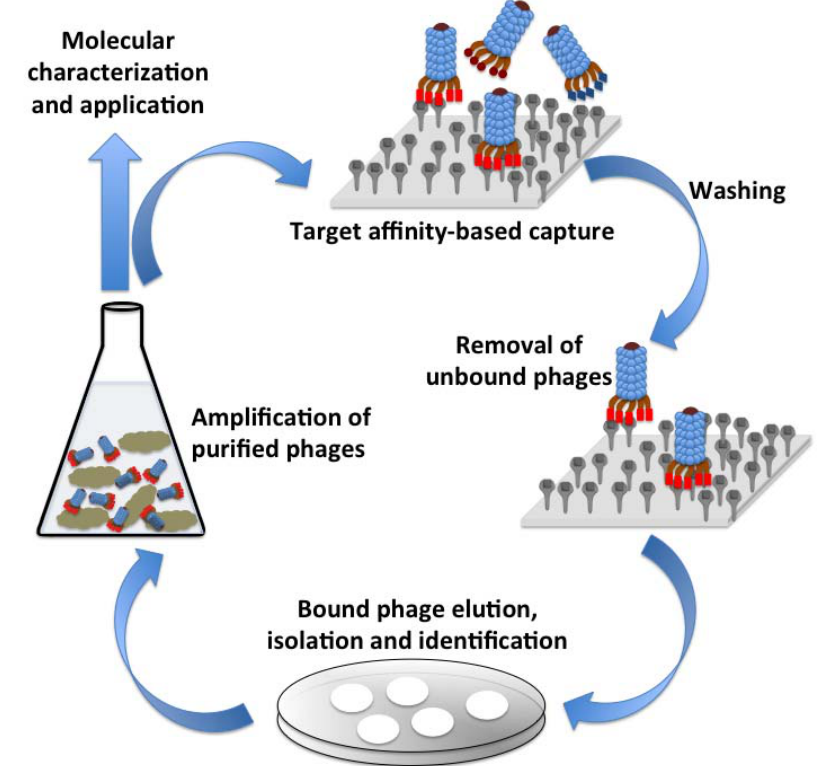
Figure 3. A schematic of affinity-based selection procedure adapted in phage display